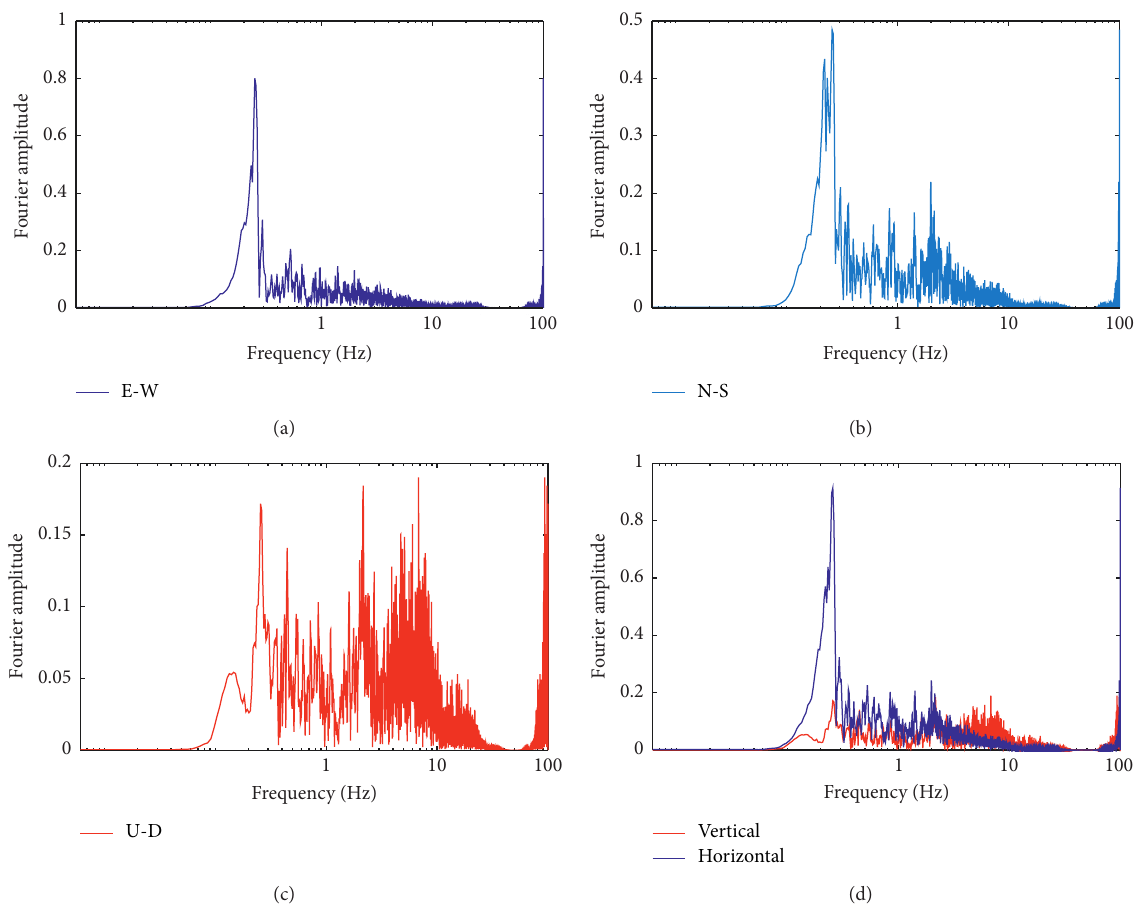
Figure 3: Fourier spectra of the Gorkha earthquake: (a) east-west (E-W) component, (b) north-south (N-S) component, (c) vertical (U-D) component, and (d) vertical and horizontal components.